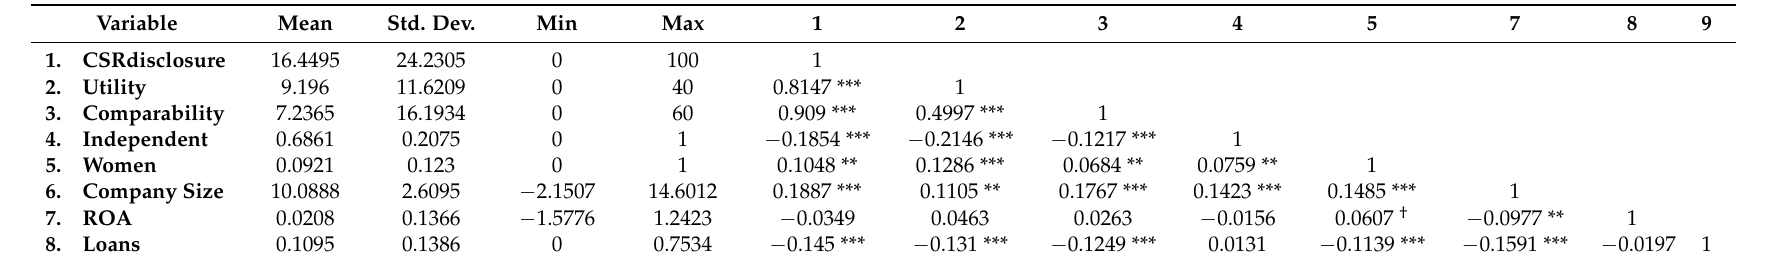
Table 4. Descriptive statistics and bivariate